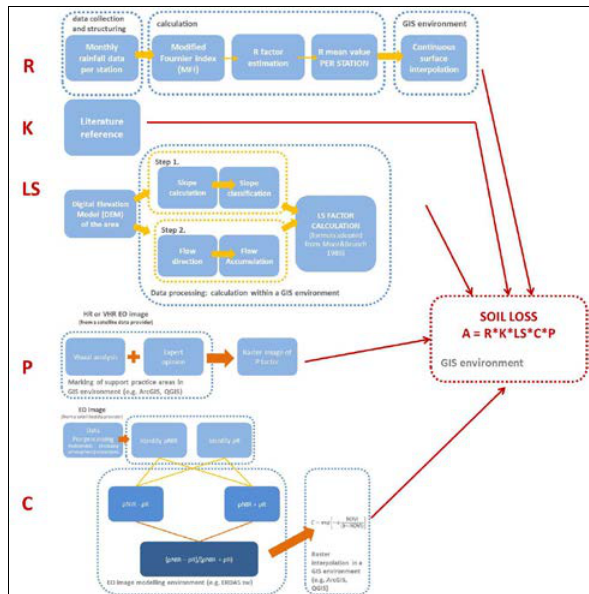
Figure 2. Overall Processing chain for Soil Loss calculation using RUSLE/USLE equation